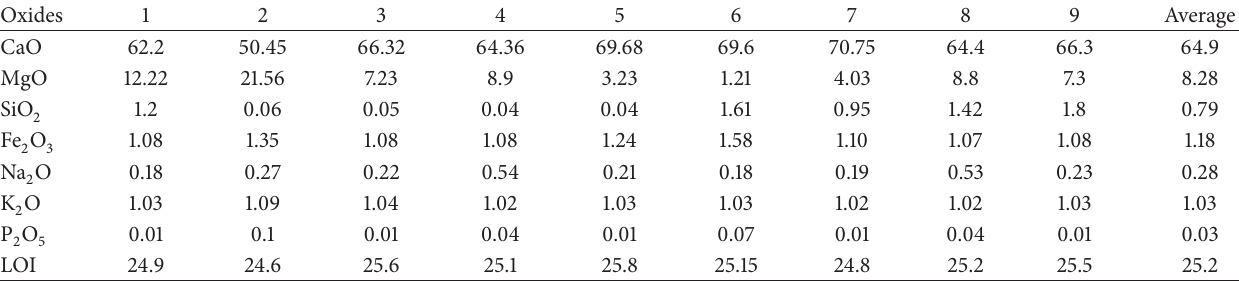
Table 4: Chemical analysis of major oxide contents (wt%) of Wadi El-Nakhil